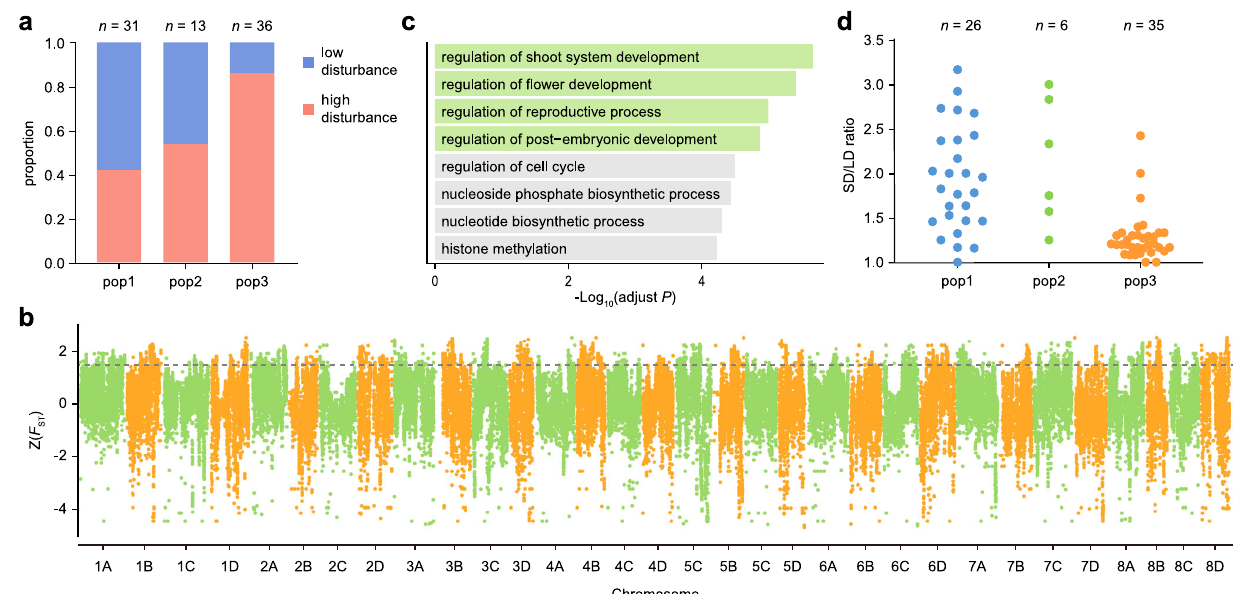
Fig.2|Adaptationofpop3tohigh-disturbanceenvironments.a Theproportion of plants from three populations in low-disturbance areas (i.e., forests and moun- tains) and high-disturbance areas (i.e., paddy fi elds, fl ower beds, and roadsides). SeealsoSupplementaryData1. b F ST valuesofpop2andpop3accessionsacrossthe whole genome. The gray dashed line represents the top 5% threshold. c GO term analyses of the genes within the top 5% F ST regions. The top eight enriched GO biological processes are shown. The biological processes shaded in green are associated with the transition from vegetative-to reproductive growth. See also